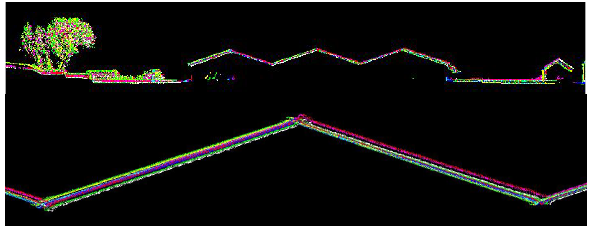
Figure 1. Strip alignment prior to corrections.